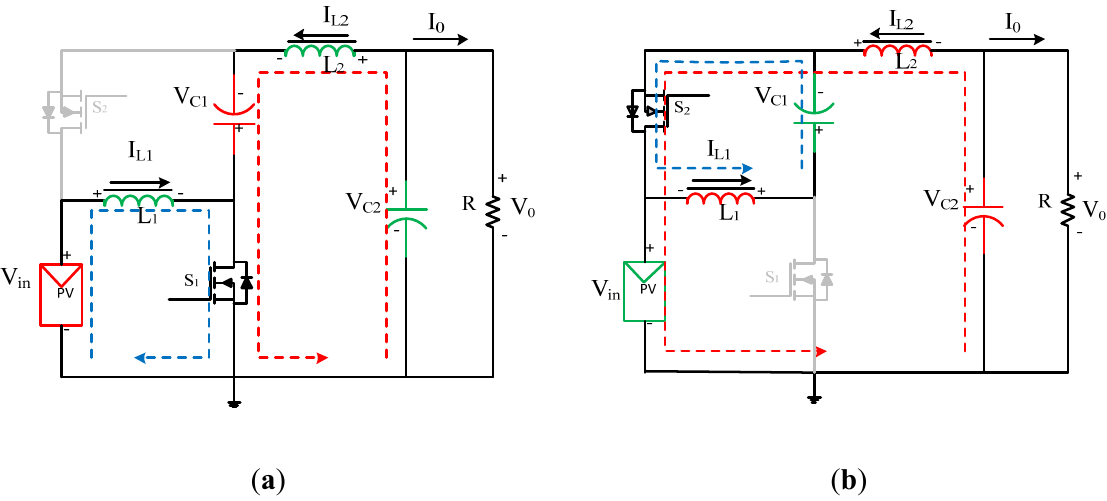
Figure 5. Modes of operation of semi-Z-source inverters when D < 0.5: ( a ) State I; ( b ) State II.